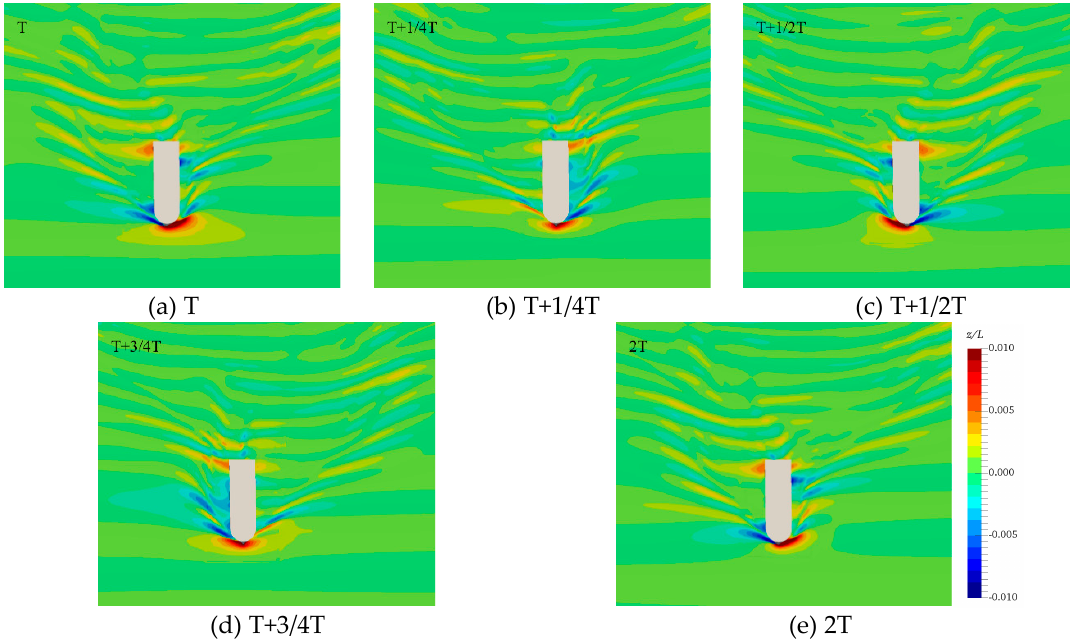
Figure 12. Evolution of free surface in one period in CASE PS8.